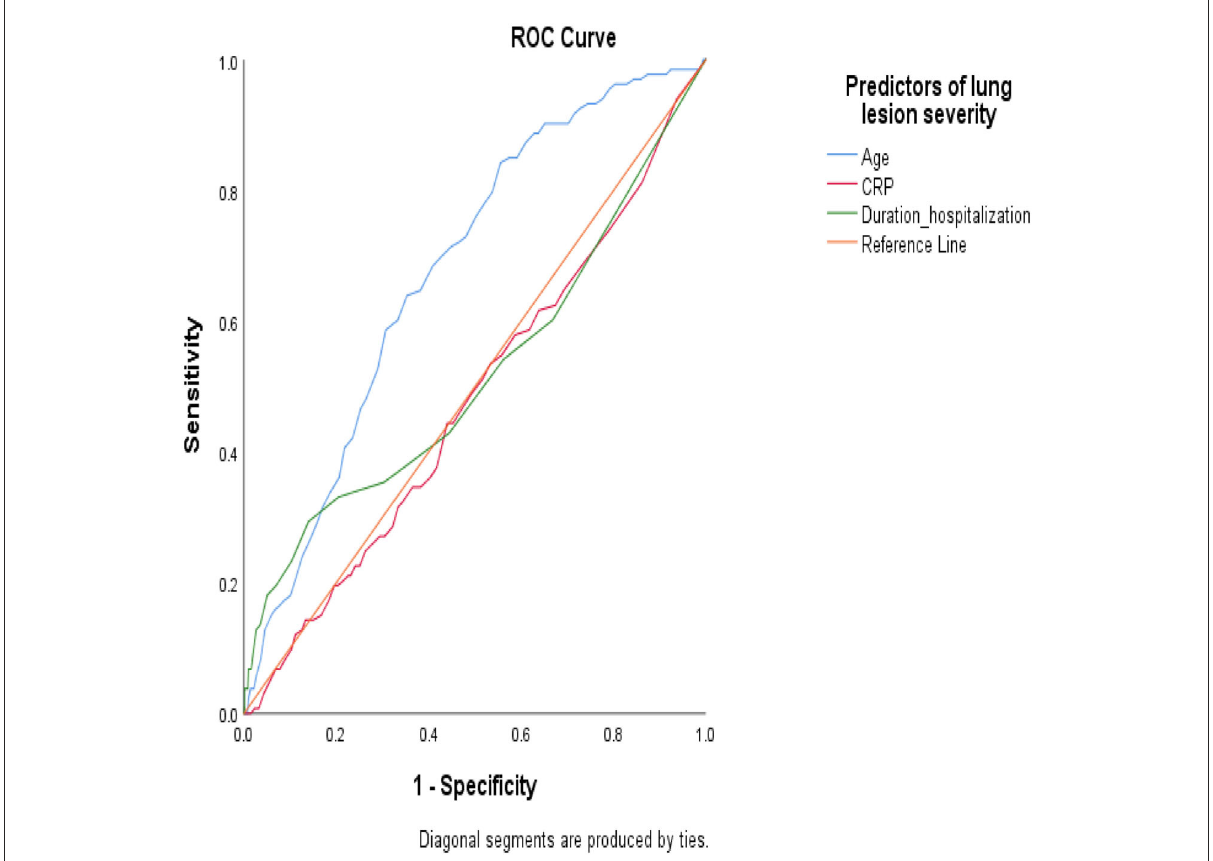
FIGURE3 Under the receiver operating characteristic (AUC-ROC) curve to study the predictive value of the most significant predictors of lung involvement severity in the likelihood of death in hospitalized patients with COVID-19 infection (training